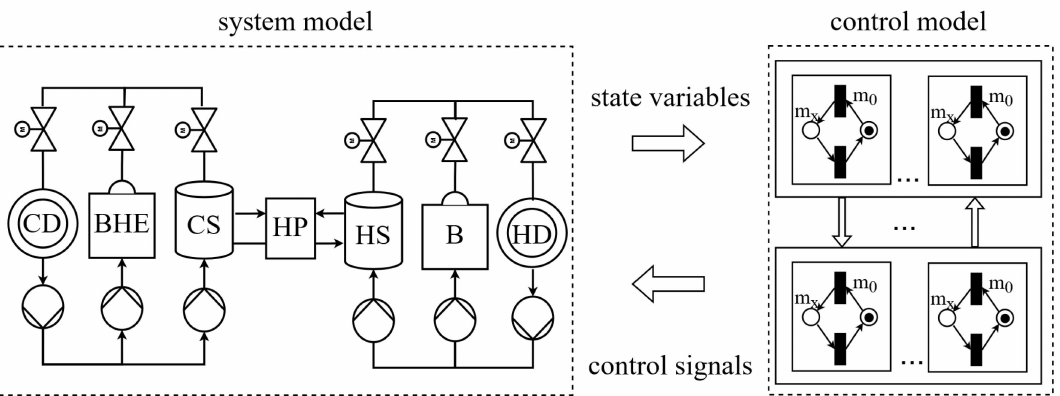
Figure 11. Modeling the energy system and the controller in the modeling language Modelica. CD: cold demand; BHE: borehole-heat-exchanger field; CS: cold storage; HP: heat pump; HS: heat storage; B: boiler; HD: heat demand; V: valve; P: pump.